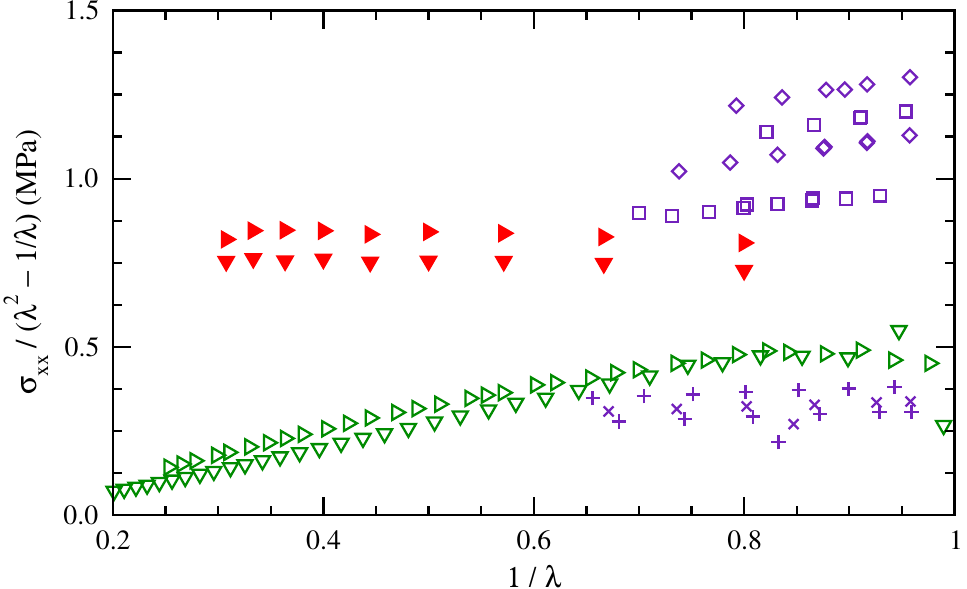
Figure 9. Mooney–Rivlin plot of normalized stress for polybutadiene as measured at 298.15 K for networks cross linked from two different starting materials ( (cid:3) , (cid:5) and × , + blue) [37] and at 273.15 and 298.15 K for a different cross-linked polybutadiene rubber ( (cid:46) , (cid:79) green) [41]. Simulation results are for cis-1,4-polybutadiene of 50 repeat units at 275 and 300 K ( (cid:72) , (cid:73)